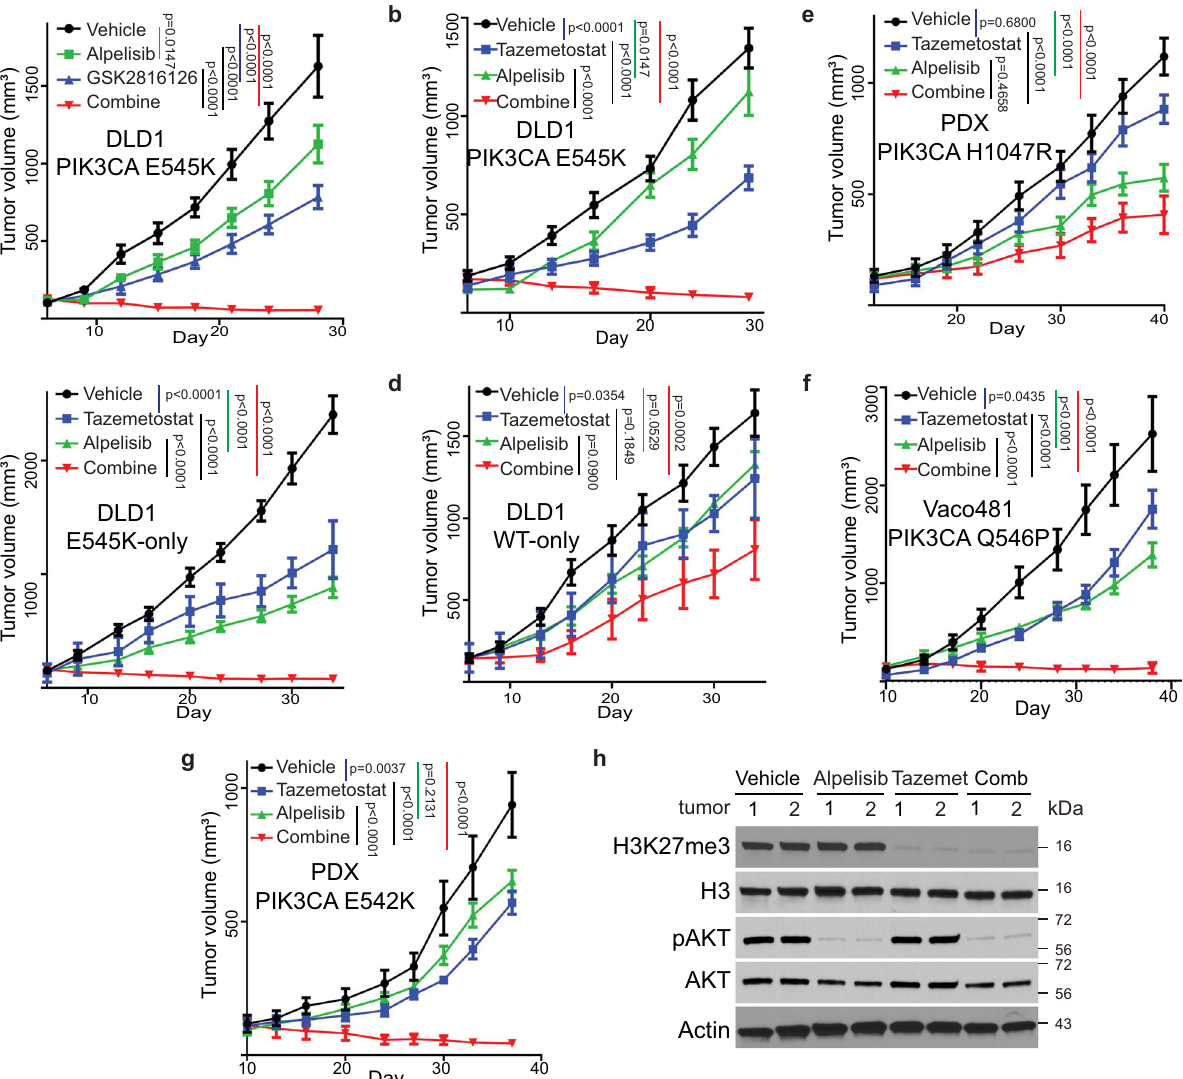
Fig. 7 A combination of p110 α and EZH inhibitors induces regression of tumors with PIK3CA helical domain mutations, but not WT or kinase domain mutation. a Subcutaneous xenograft tumors established from DLD1 cells were treated with vehicle or the indicated drugs. GSK2814126: an EZH2 inhibitor; Alpelisib: a p110 α -speci fi c inhibitor. b – g Tumors are treated with an EZH inhibitor Tazematostat (EPZ-6438), Alpelisib, or the drug combination. Subcutaneous xenograft tumors established from DLD1 parental cells ( b ), DLD1 PIK3CA E545K-only cells ( c ), DLD1 PIK3CA WT-only cells ( d ); a